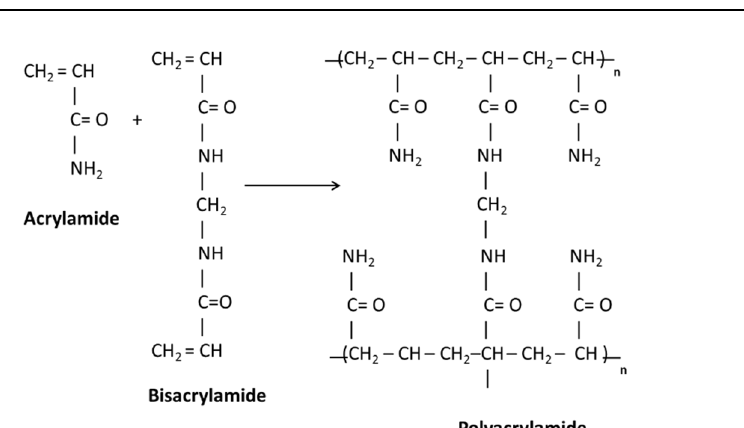
Figure 2. Crosslinking reaction between acrylamide and bisacrylamide to produce crosslinked polyamide